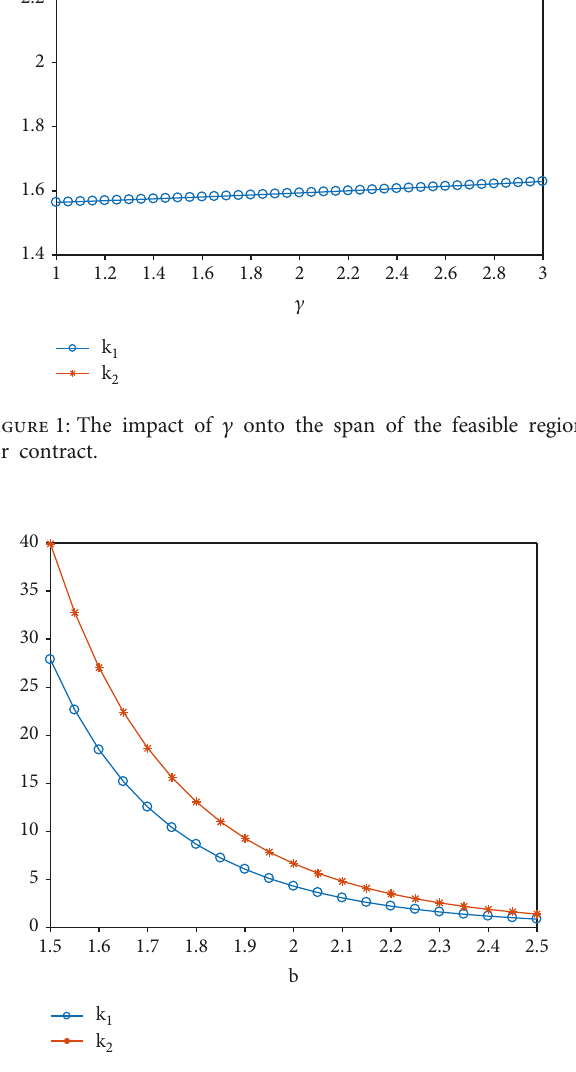
Figure 2: The impact of b onto the span of the feasible region for contract.